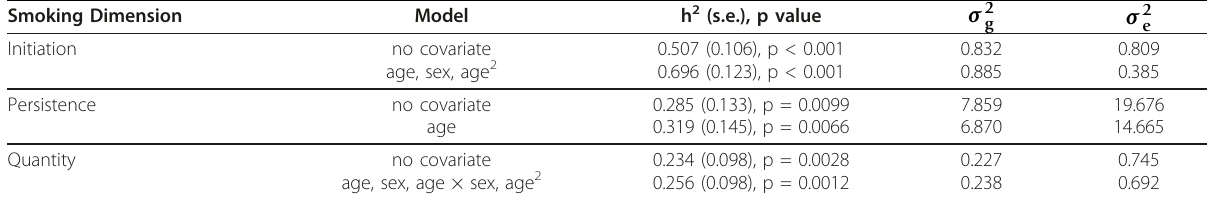
Table 3 Heritability estimates for smoking initiation, persistence, and quantity in Brazilian families. Smoking